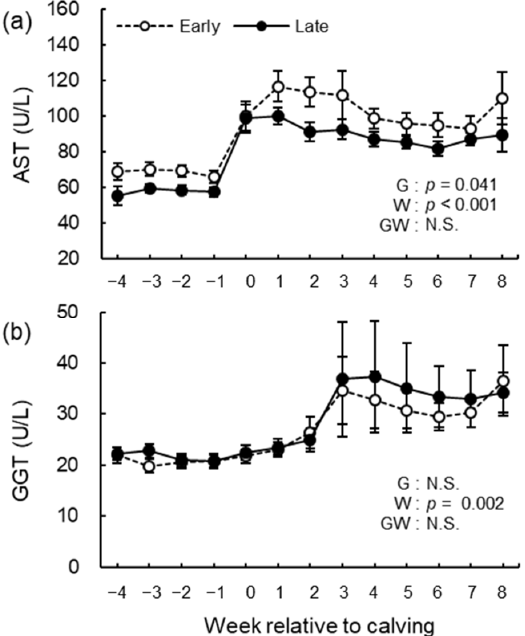
Figure 10. Serum concentrations of ( a ) aspartate aminotransferase (AST) and ( b ) glutamate dehy- drogenase (GGT) from −4 to 8 wk relative to calving for cows classified into the early group (Early) and the late group (Late). Early = cows with endometrial inflammation converged within 4 wk, n = 17; Late = cows with endometrial inflammation converged at or after 5 wk, n = 16. The week of calving is defined as 0 wk. G = group effect; W = week effect; GW = group-by-week interaction. Data are shown as mean ± SEM.